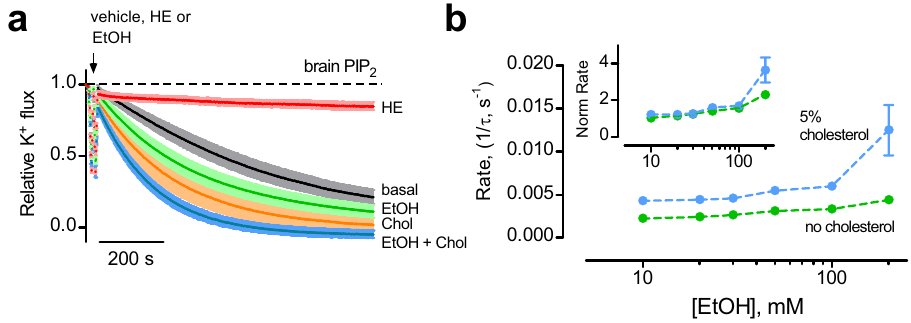
Figure 6. Cholesterol does not affect the ethanol sensitivity of GIRK2 channels. ( a ) Normalized fluorescent traces (mean ± SEM) show the K + flux for GIRK2-containing liposomes with 1% brain PIP 2 (black trace), and either 100 mM EtOH (green), 5% cholesterol (orange), or both 100 mM EtOH and 5% cholesterol (blue trace) (n = 4–12) ( b ) The rate of K + flux for GIRK2 with PIP 2 and 5% cholesterol (blue) or PIP 2 alone (green) is plotted as a function of different EtOH concentrations. Inset, the normalized rate of K + flux is plotted as a function of EtOH